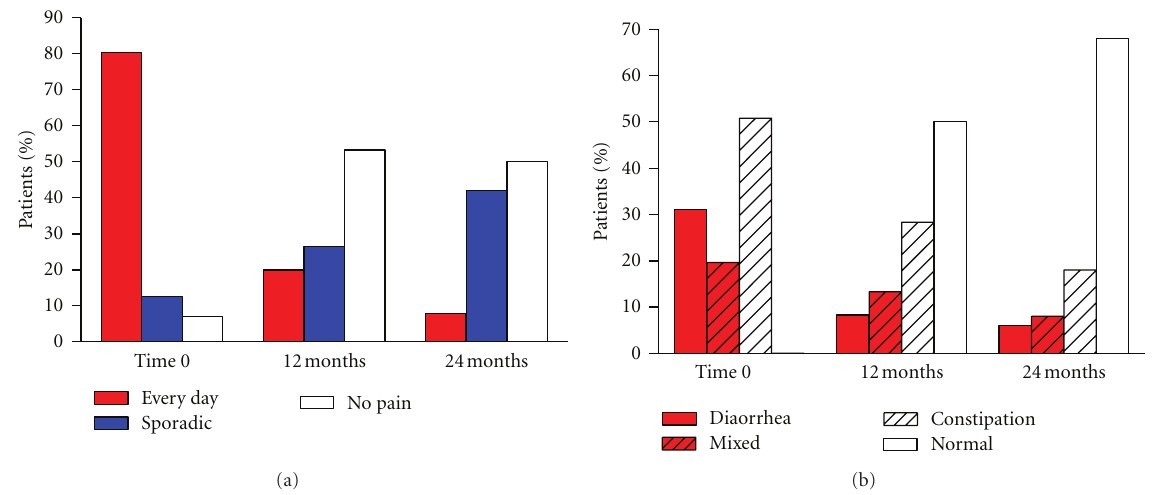
Figure 5: E ff ect of long-term treatment with otilonium bromide on pain episodes (a) and bowel habits (b) reported by patients. Modified from [10].